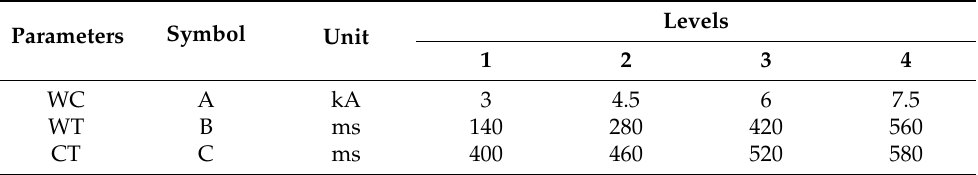
Table 3. Parameters and their levels for DPW scheme. (Reprinted from [26] with permission from Elsevier) Table 4. Taguchi L16 (OA) for experimental design of DPW scheme. Sample No.